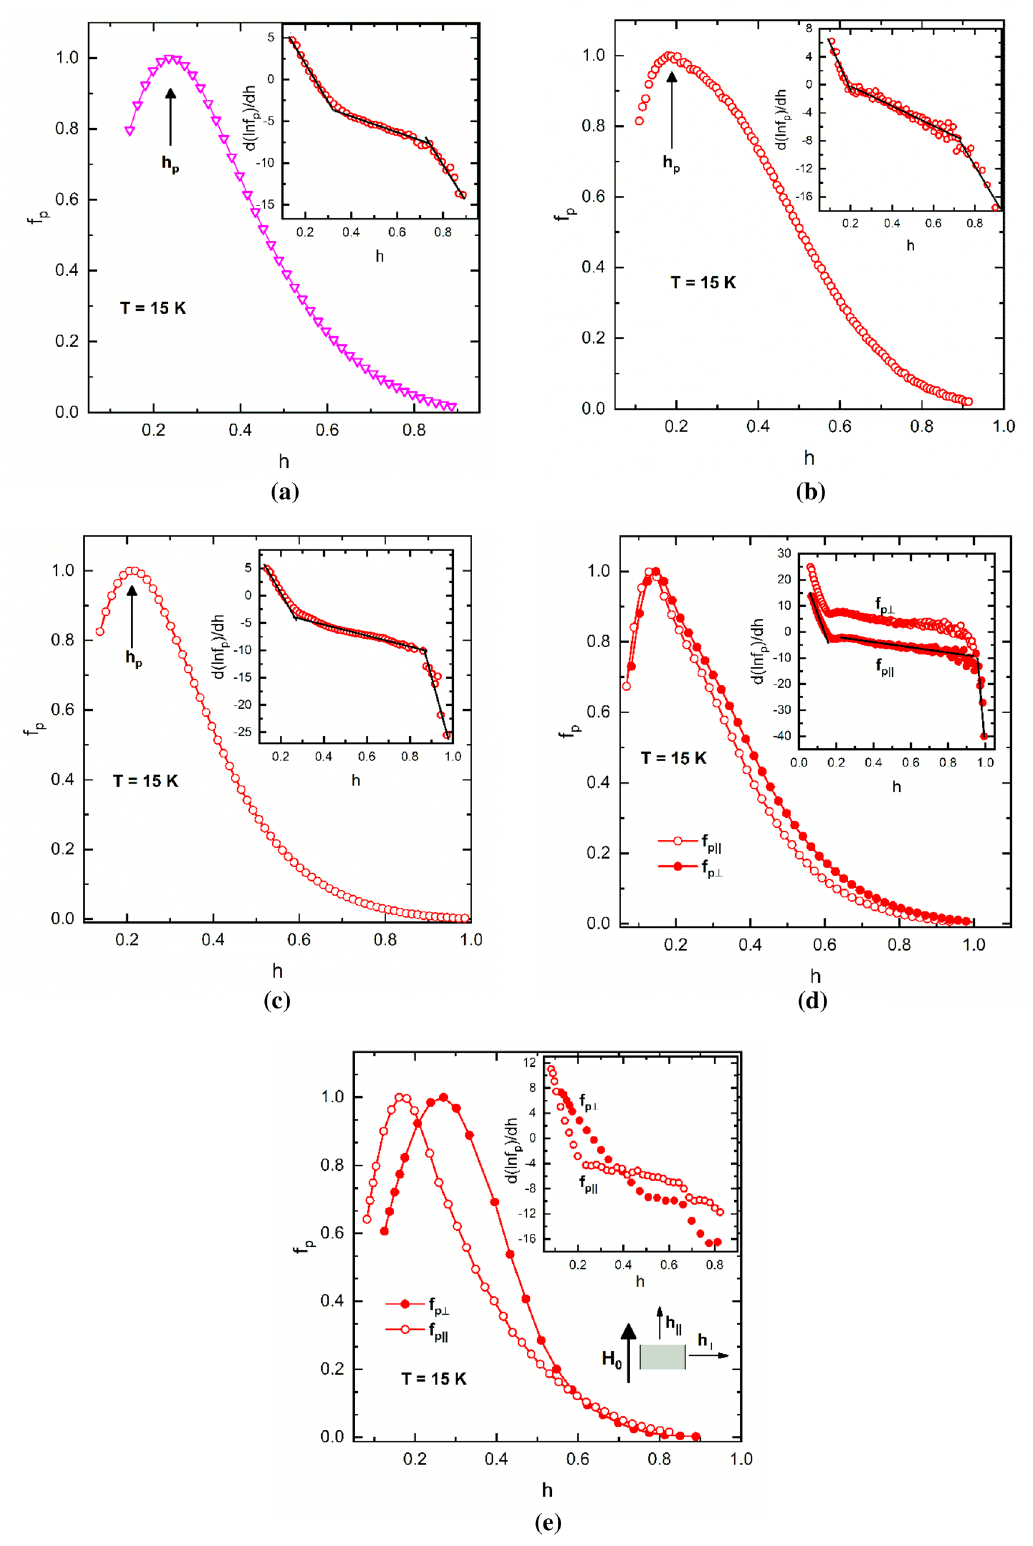
d ( ln f p ) dh (Insets) on the